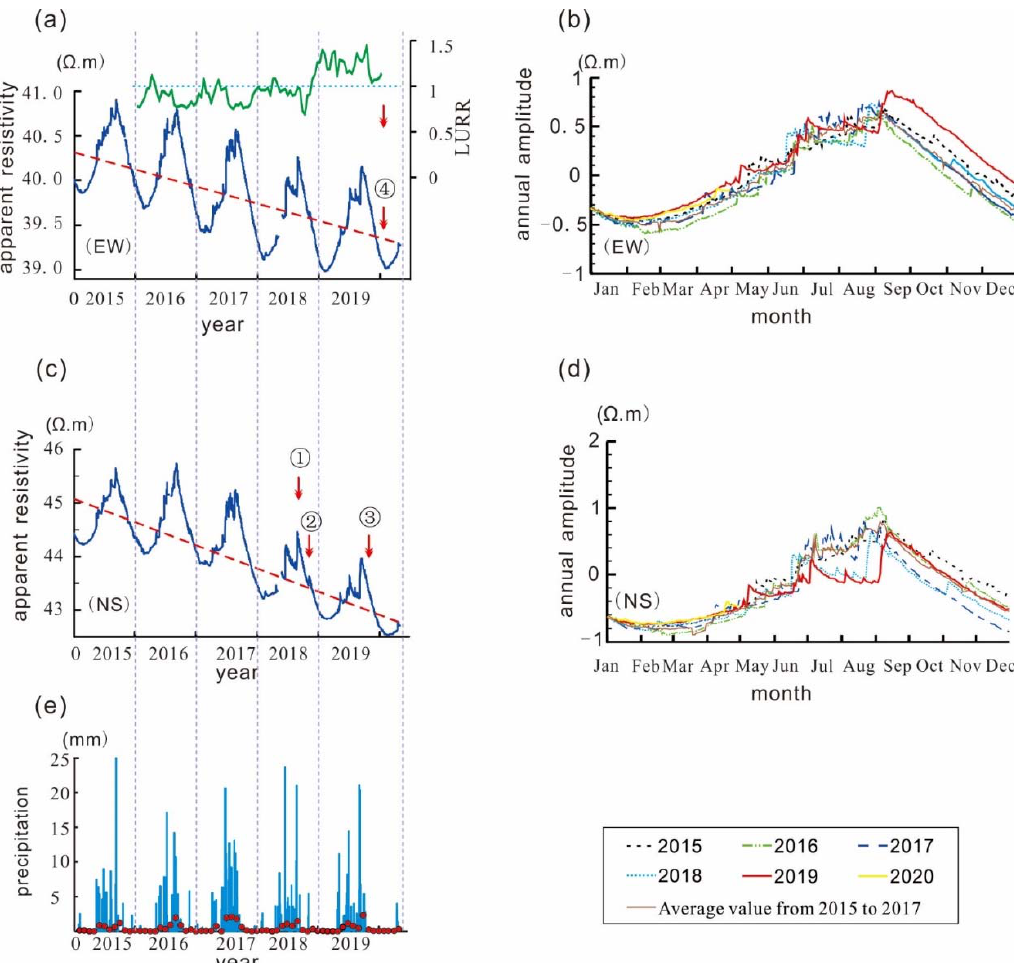
Figure 3. Plots of the apparent resistivity recorded at the Kalpin Observatory: ( a ) the blue curve is the E–W daily average of apparent resistivity, and the green curve is the temporal curve of LURR mean value within 150 km around Kalpin observatory, ( b ) annual variation of the E-W direction, ( c ) N–S daily average, ( d ) annual variation of the N-S direction, and ( e ) precipitation data for 2015–2019 (from the Kalpin Meteorological Station). Blue columns indicate daily precipitation and red dots indicate the monthly precipitation averages. ① , ② , ③ , and ④ represent the Jiashi Ms 5.5 earthquake on 4 September 2018, the Atushi Ms 5.1 earthquake on 4 November 2018, the Wushi Ms 5.0 earthquake on 27 October 2019, and the Jiashi Mw 6.0 earthquake on 19 January 2020.